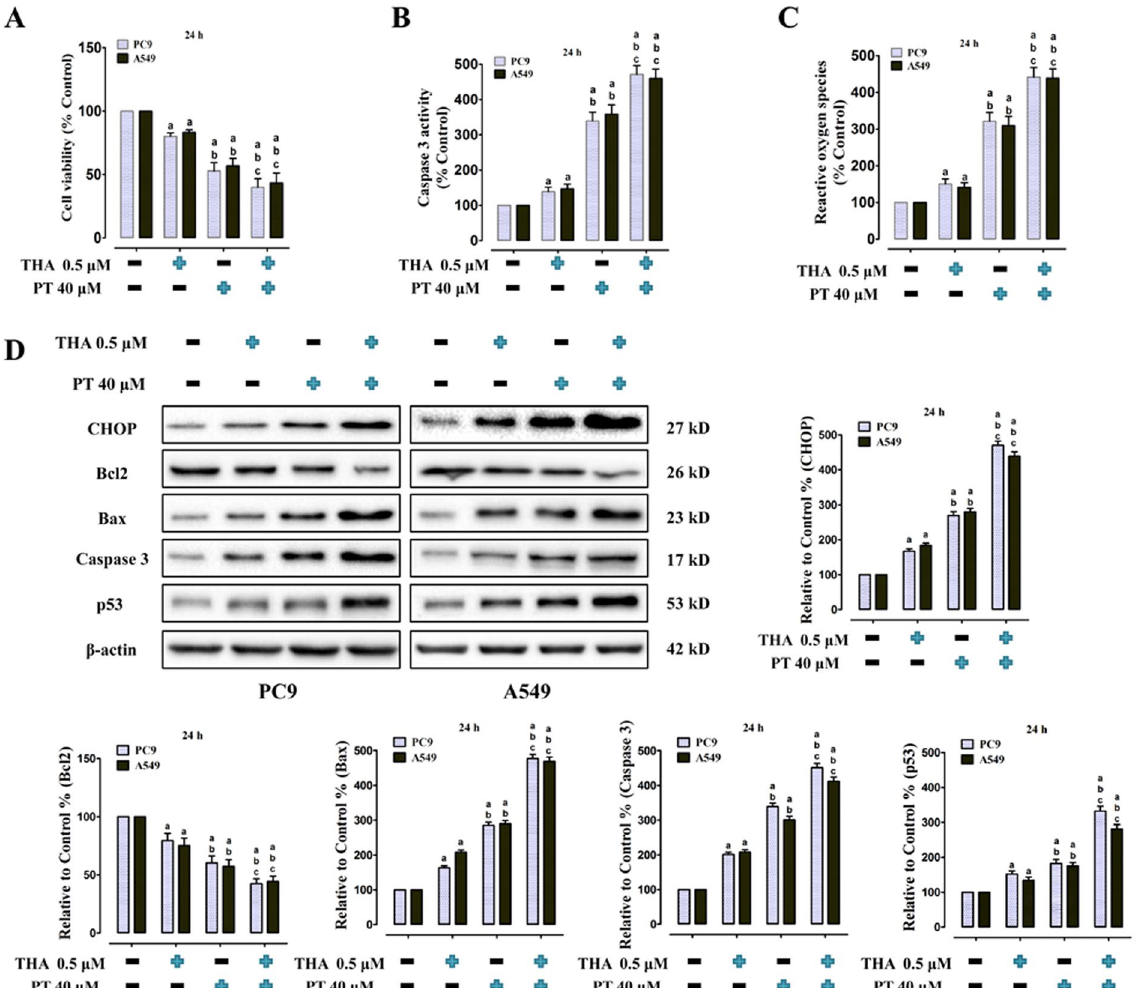
Figure 7. Effect of PT treatment combined with THA on cell viability, Caspase 3 activity, ROS generation, CHOP and apoptosis-related protein levels in PC9 and A549 cells (24 h). ( A ) Cell viability; ( B ) Intracellular Caspase 3 activity; and ( C ) ROS concentration were shown, and those three indexes in the control group were defined as 100%. ( D ) Representative western blot results of the key proteins, including CHOP, Bcl2, Bax, Caspase 3, and p53 were shown. Membranes were re-probed for β -actin expression to show that similar amounts of protein were loaded in each lane. The results were expressed as the mean ± SD; n = 6. a P < 0.05 vs . the control group, b P < 0.05 vs . the 0.5 μ M THA-treated group, c P < 0.05 vs . the 40 μ M PT-treated